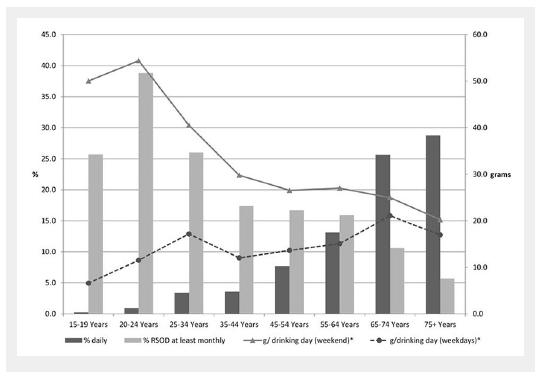
Percentage of daily and risky single occasion drinkers (RSOD) and grams of alcohol consumed on weekend days and weekdays by age group in 2011. Note: *among drinkers only (n = 5,840); data from